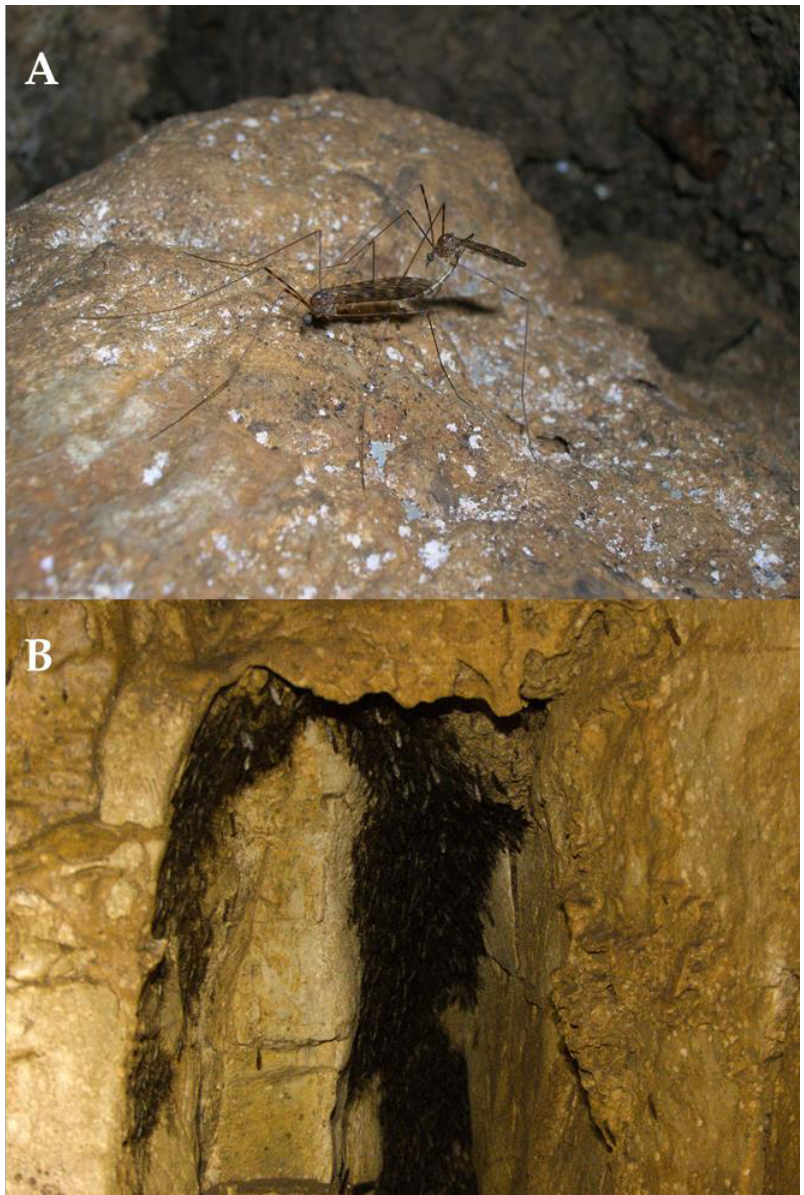
Figure 1. Two photos showing crane flies in subterranean environments: ( A ) two individuals mating and ( B ) high density aggregation. Photo credit: Enrico Lunghi.